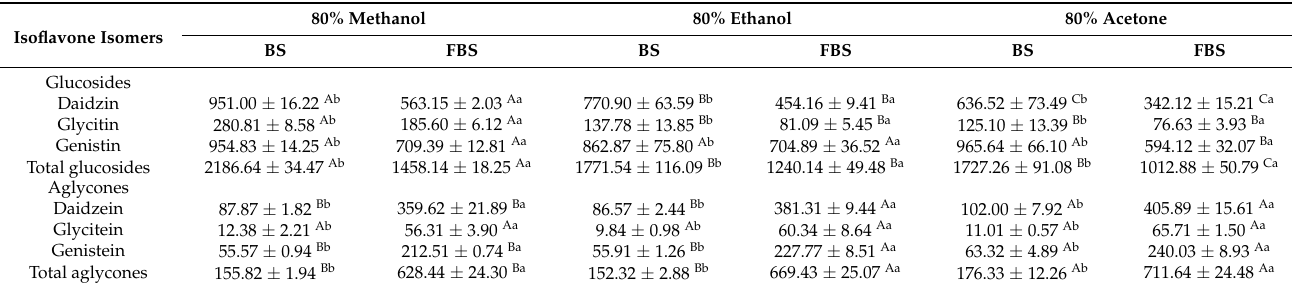
Table 5. HPLC analysis result of isoflavone compositions ( µ g/g DW) of E. cristatum -fermented and non-fermented black soybeans.